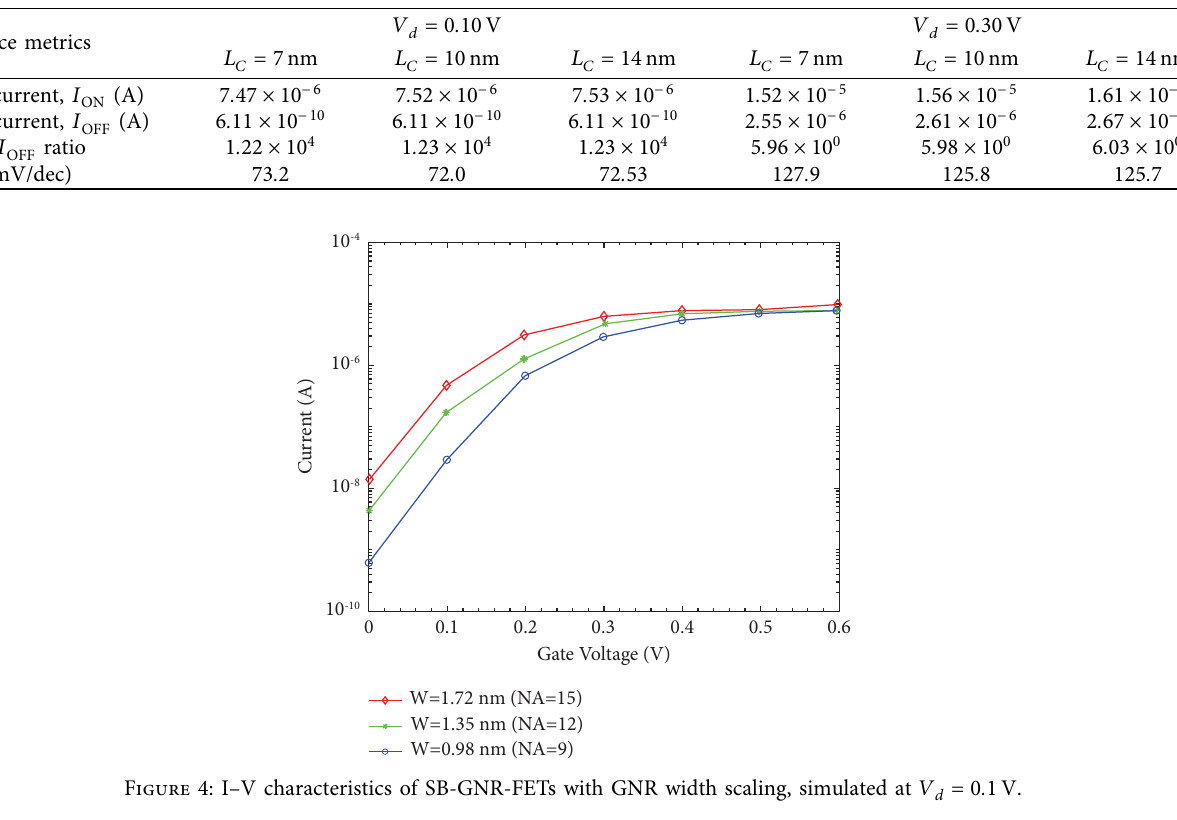
Table 2: Device performance of SB-GNR-FETs with channel length scaling.